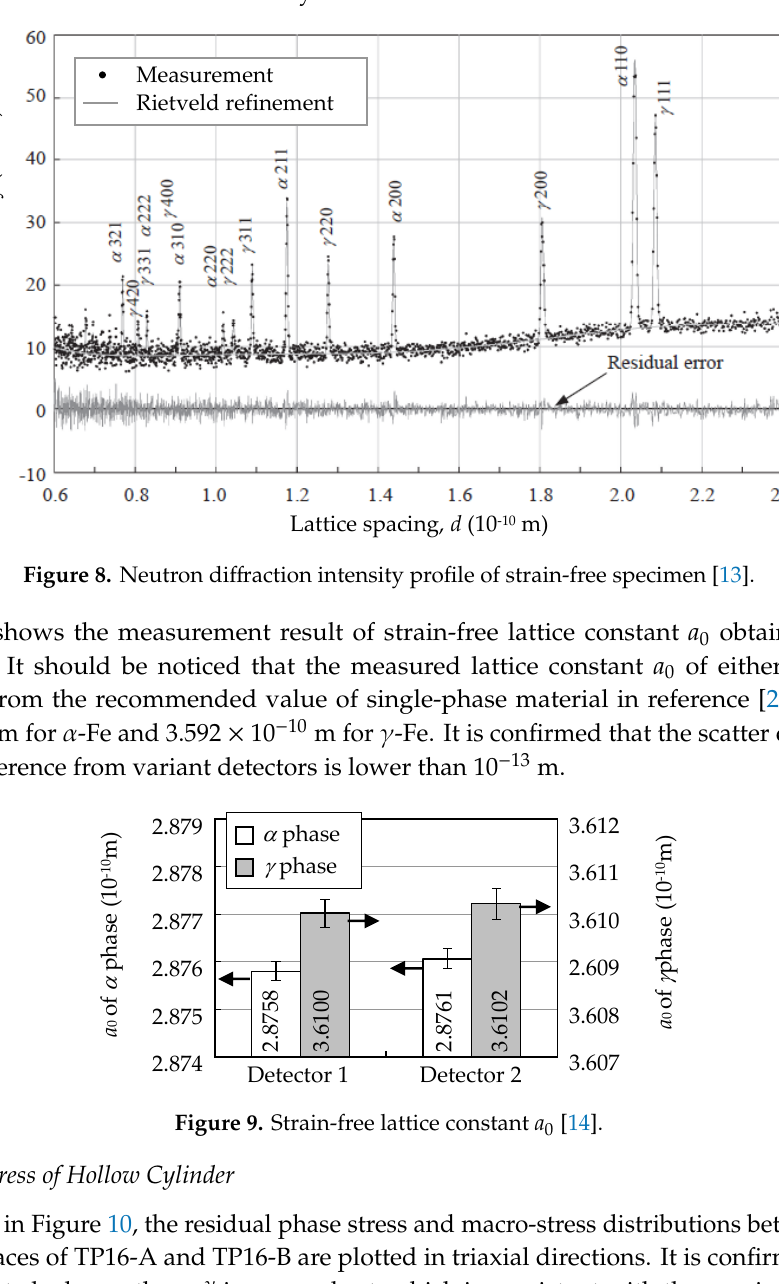
Figure 9. Strain-free lattice constant a 0 [14].